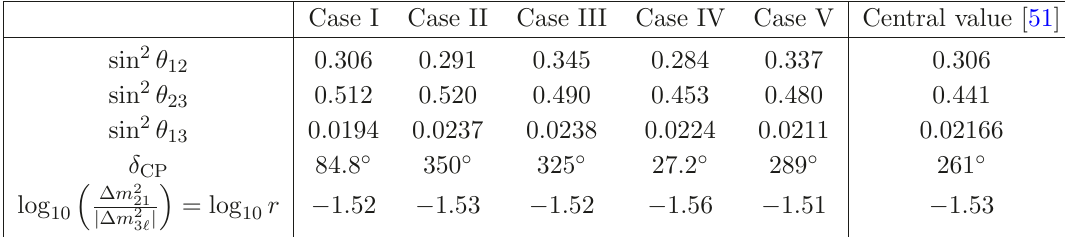
Table 3 . The results for the mixing angles, CP phases, and mass squared differences.